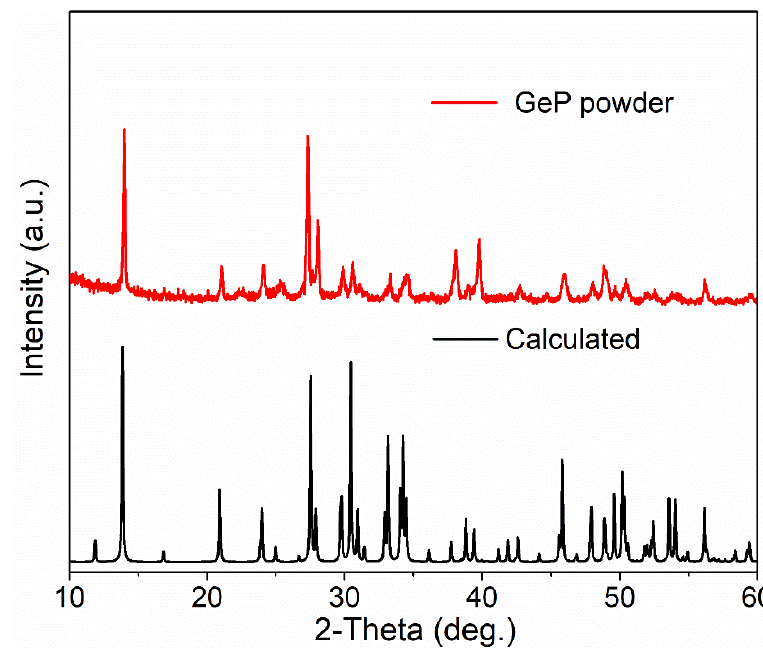
Figure 2. XRD patterns of GeP powder and the calculated values.